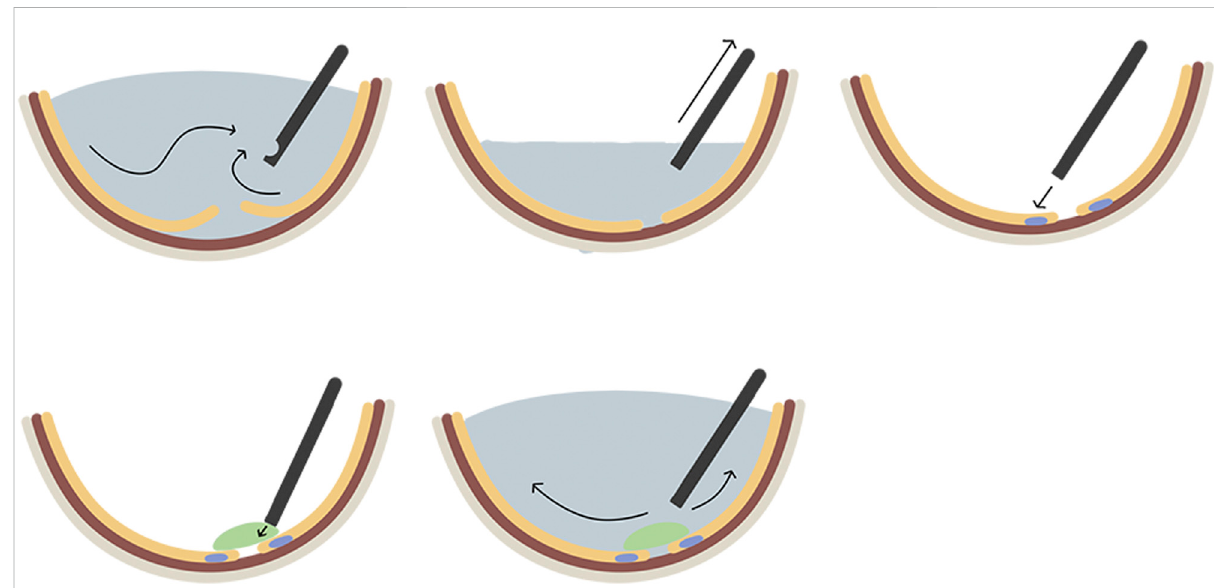
FIGURE 3 The general surgical steps of applying biomaterials as retinal patches for the repair of rhegmatogenous retinal detachment. A. complete pars plana vitrectomy; B. fl uid-air exchange to remove subretinal fl uid and achieve retinal reattachment; C. laser photocoagulation around retinal break;